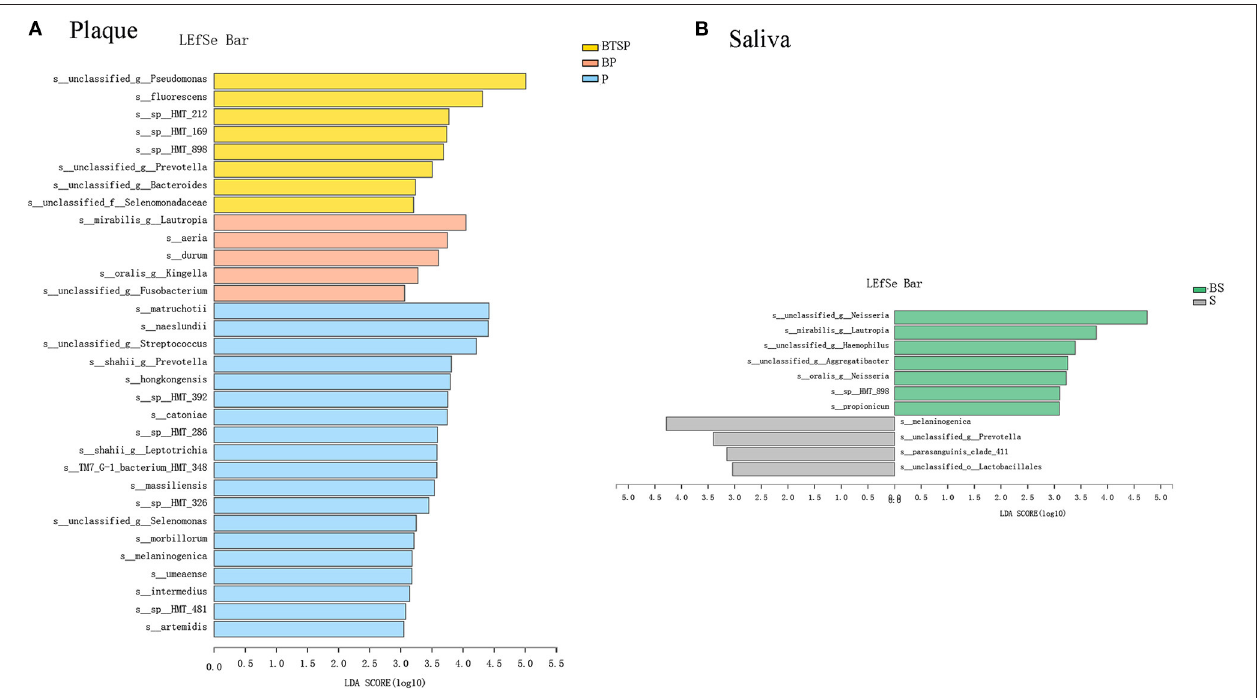
FIGURE 2 | Comparisons of the relative bacterial abundance in the BTS and control groups; LDA revealed significant variations in the levels of bacterial species [LDA Score (log10) > 3]. (A) Plaque samples. (B) Saliva